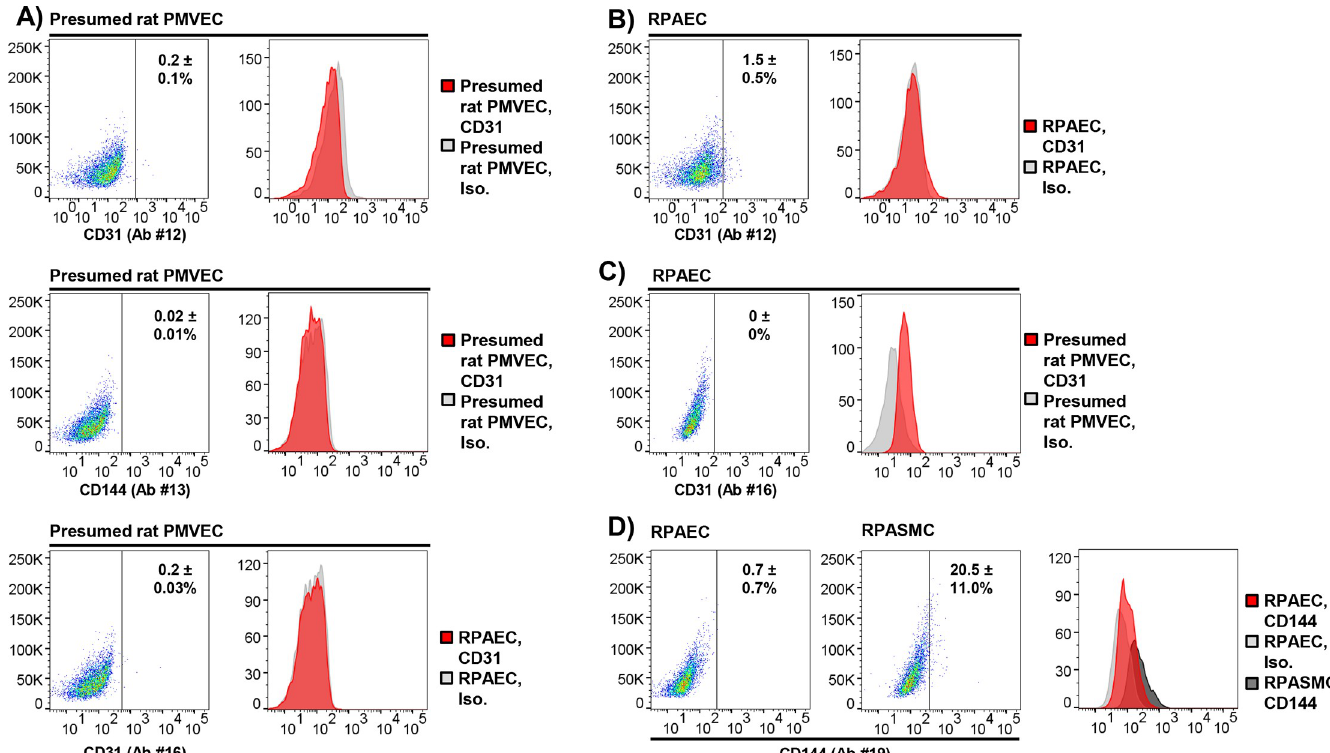
Fig 4. Identifying rat pulmonary endothelial cells by flow cytometry. Presumed rat PMVECs isolated by mechanical and enzymatic dissociation of peripheral lung and culture in endothelial-selective medium, commercial rat pulmonary artery endothelial cells (RPAECs), or rat pulmonary artery smooth muscle cells (RPASMCs) were labeled with antibodies against endothelial surface markers. (A) Anti-CD31 (Ab #12 and #16) and CD144 (Ab #13) signal was not observed in presumed rat PMVECs by flow cytometry (N = 3/condition). (B) Labeling of RPAECs was also not observed for anti-CD31 antibodies #12 (N = 4/condition) and (C) #16, respectively (N = 3/condition). (D) False-positive signal was detected in RPASMCs labeled with anti-CD144 Ab #19 (N = 4/condition). Representative plots and histograms shown. Means ± standard error, % CD31 or CD144 positive. Ab, antibody; Iso, Isotype control.